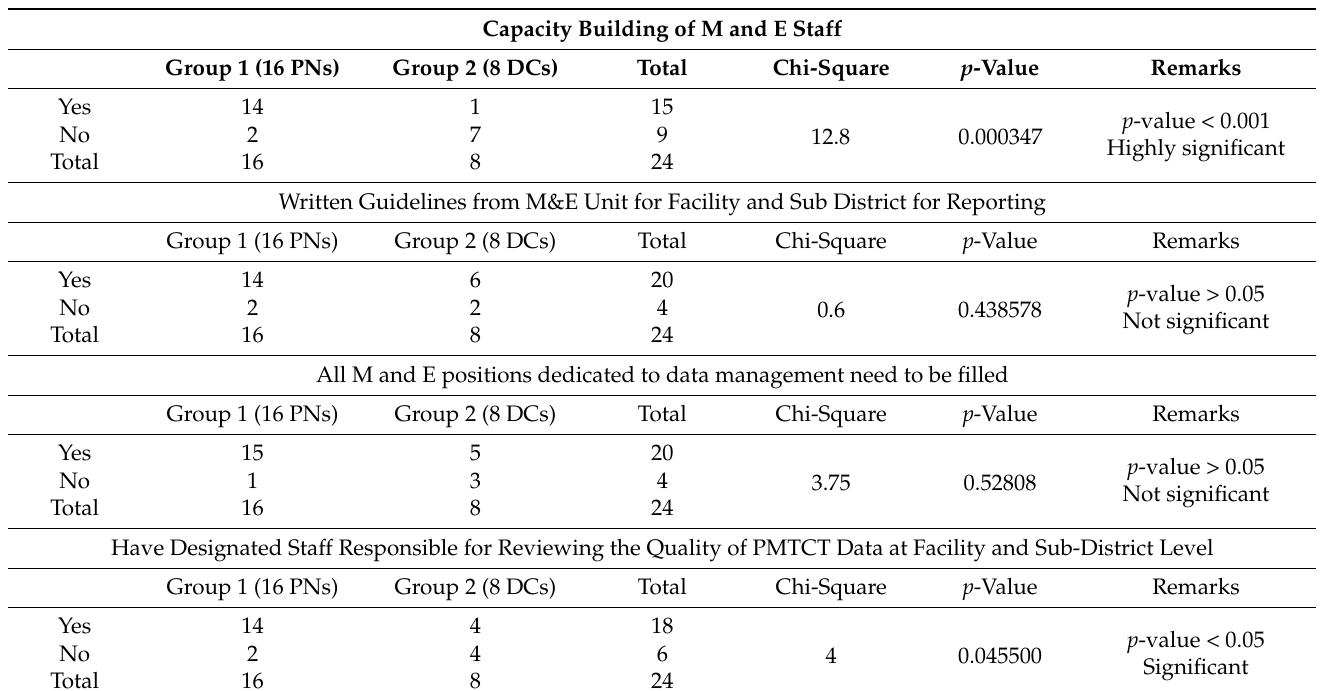
Table 3. Participants opinion about what can be done to address PMTCT data